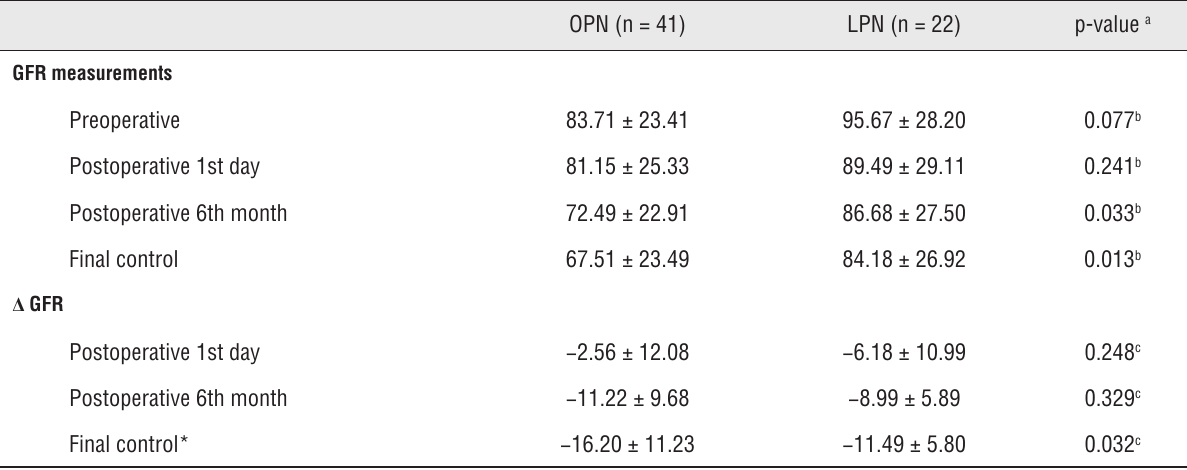
Table 4 - Effects of open and laparoscopic partial nephrectomy on renal function